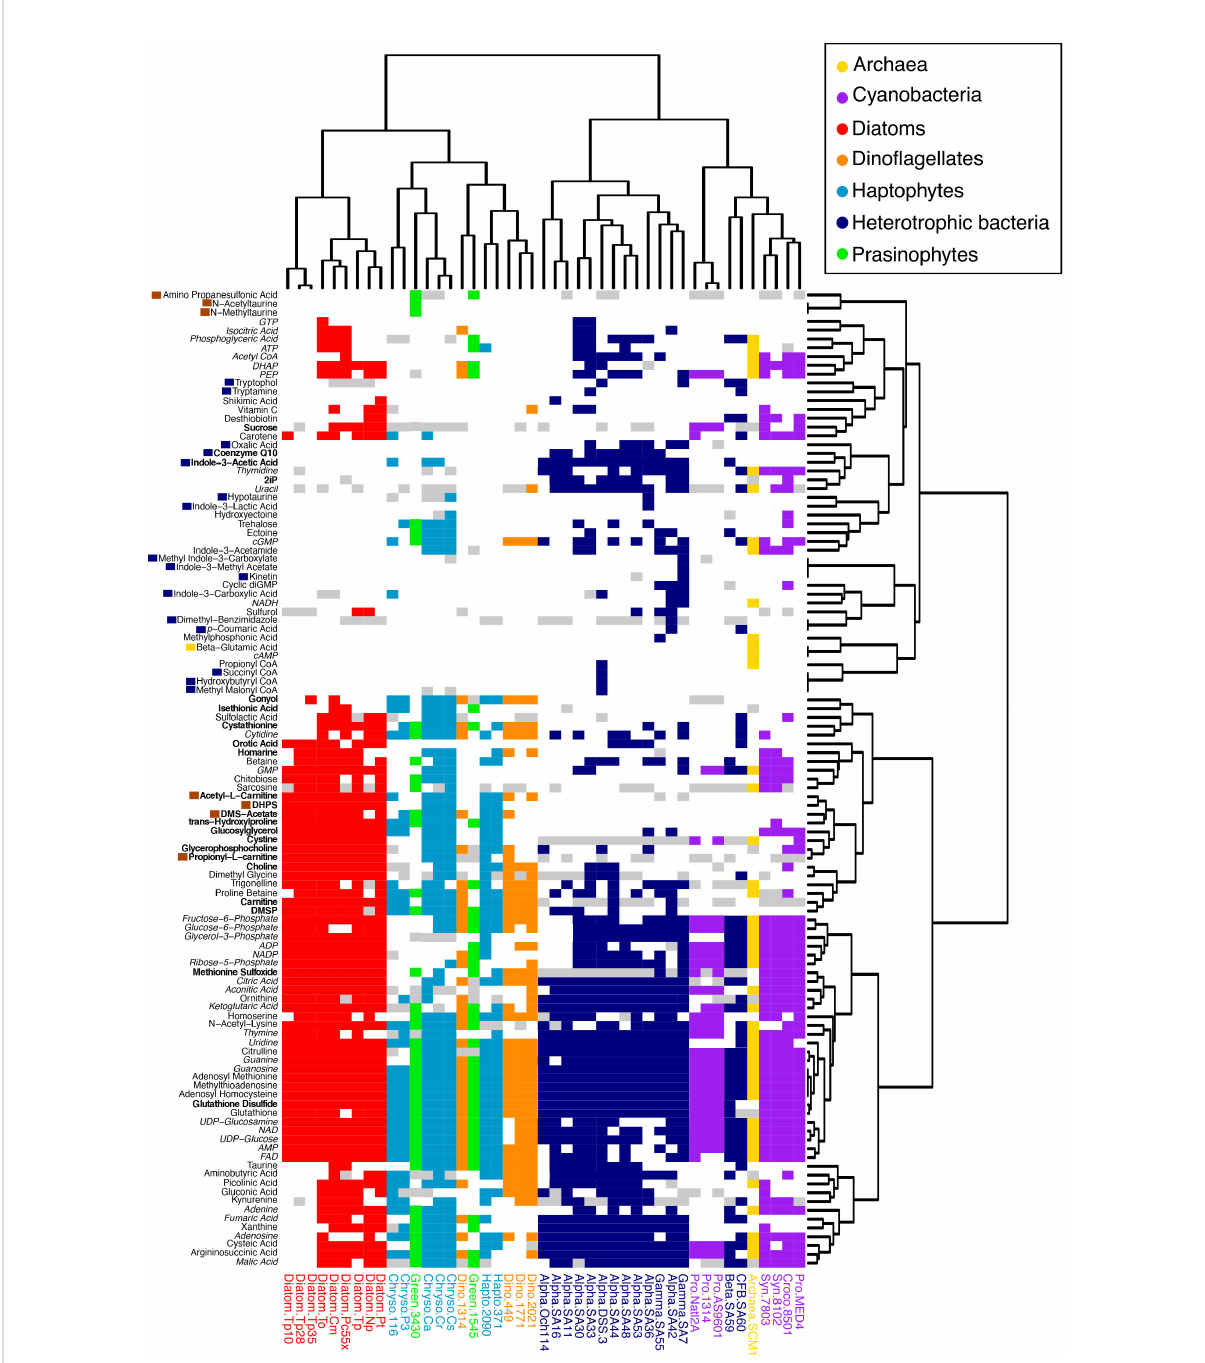
FIGURE 2 Distribution of 111 metabolites across 42 microbial taxa. Heatmap and hierarchical clustering dendrograms based on Jaccard distance using presence-absence of metabolites. Metabolite presence is colored according to the taxonomic groups in the legend, with white=metabolite absent and gray=metabolite similar to background levels. Metabolites in italics include universal electron transfer metabolites and nucleobases and their derivatives that are expected to be present in all organisms, though in some cases were not detected. Metabolites with dark blue boxes were restricted to heterotrophic bacteria, metabolites with brown boxes were restricted to eukaryotic phytoplankton, and one metabolite with a yellow box was restricted to the archaeal culture; note that non-axenic Chrysochromulina strains were not considered in this labeling scheme. Metabolites in bold were found to correspond with taxonomic groupings (see Figure 5). Organism labeling and coloring scheme are the same as in Figure